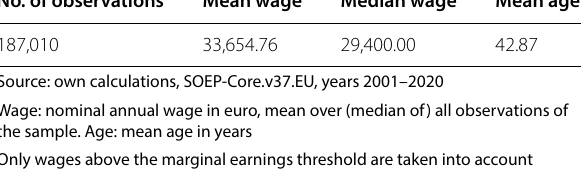
Table 4 Summary statistics SOEP: comparable sample 2 No. of